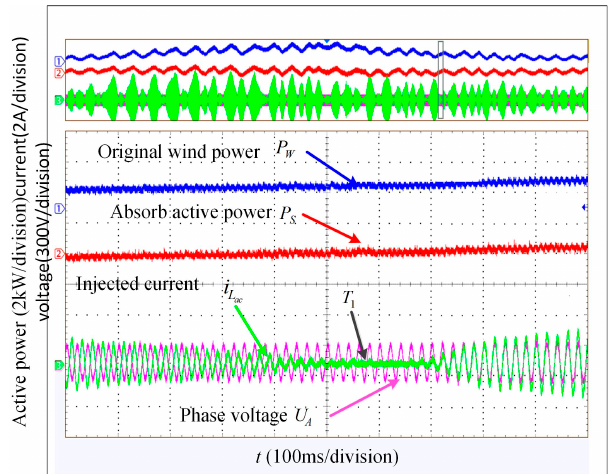
Figure 19. Experimental results when the SOC of battery groups is maintained at the lowest level of the security zone.